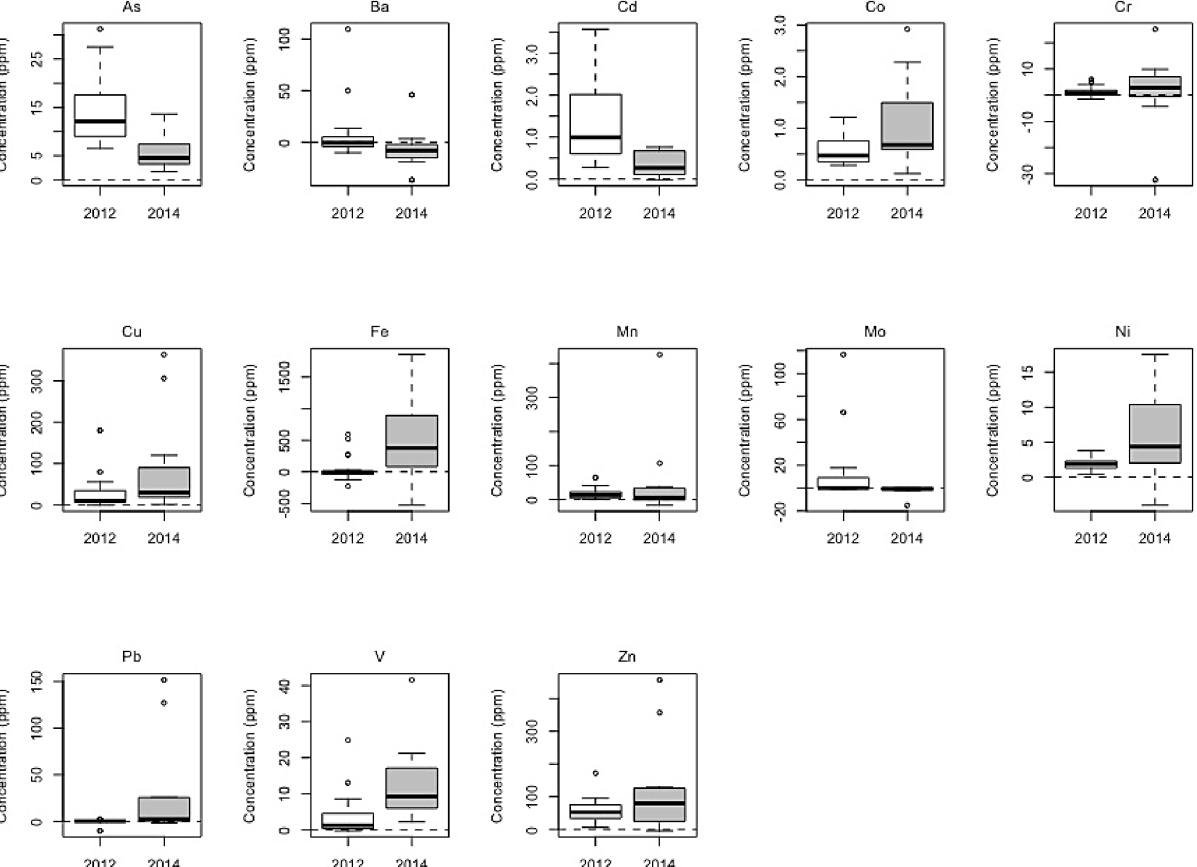
Figure 5. Box plots for statistical texts. Traditional box plot where the whiskers extend to 1.5 times in the interquartile range and then any points that fall outside of that are shown as individual dots on the graph. The dashed line at zero serves as an indicator of where the distribution lies relative to